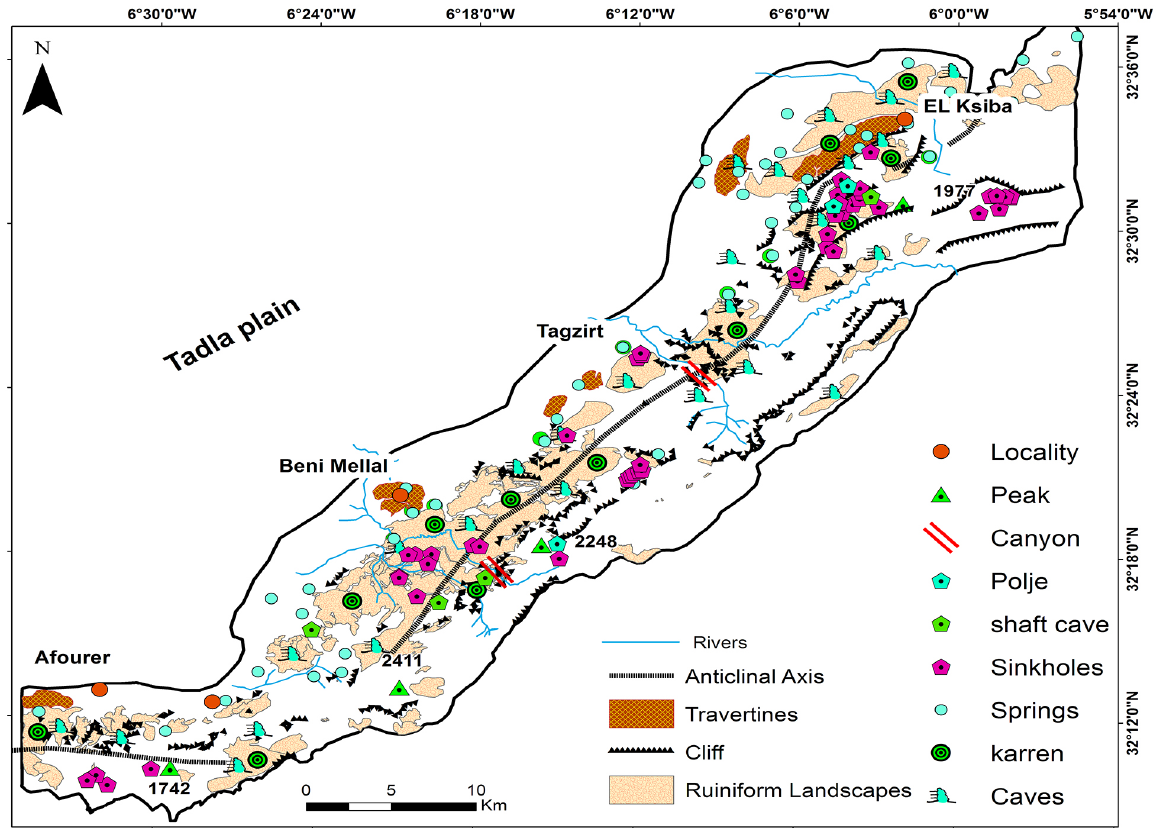
Fig. 3. Geomorphological synthesis